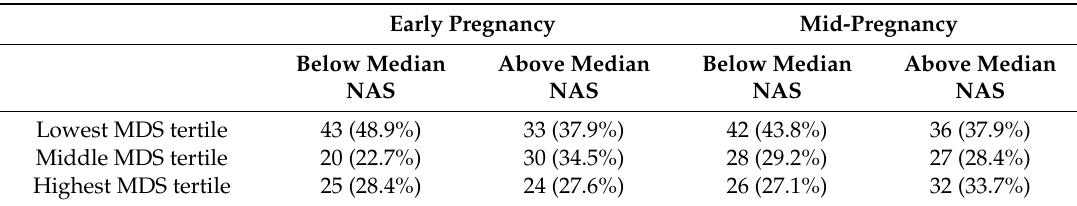
Table 2. Distribution of women in each tertile of the MDS according to the median split of the NAS within early and mid-pregnancy time